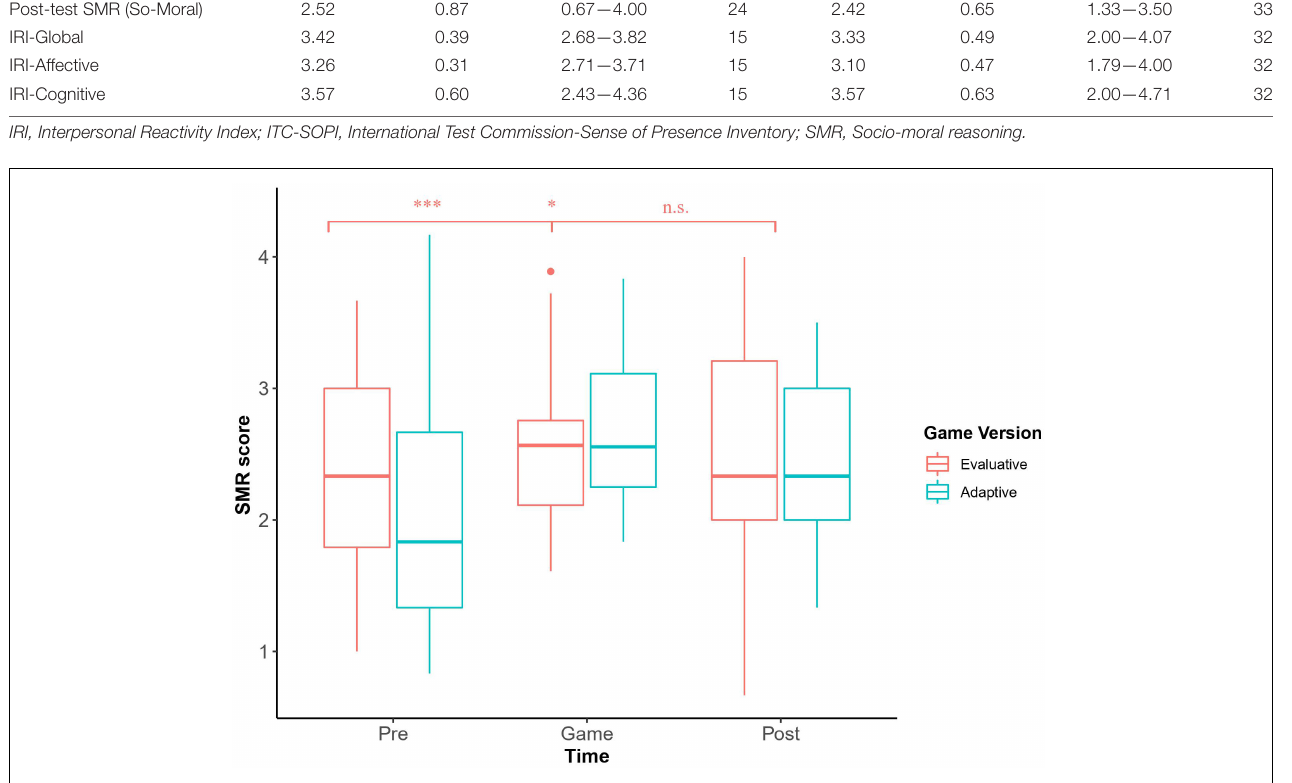
significant difference was found between the in-game and post- test scores, ( t (64) = 1.71, p = 0.21). The visual representation of those results can be see in Figure 2